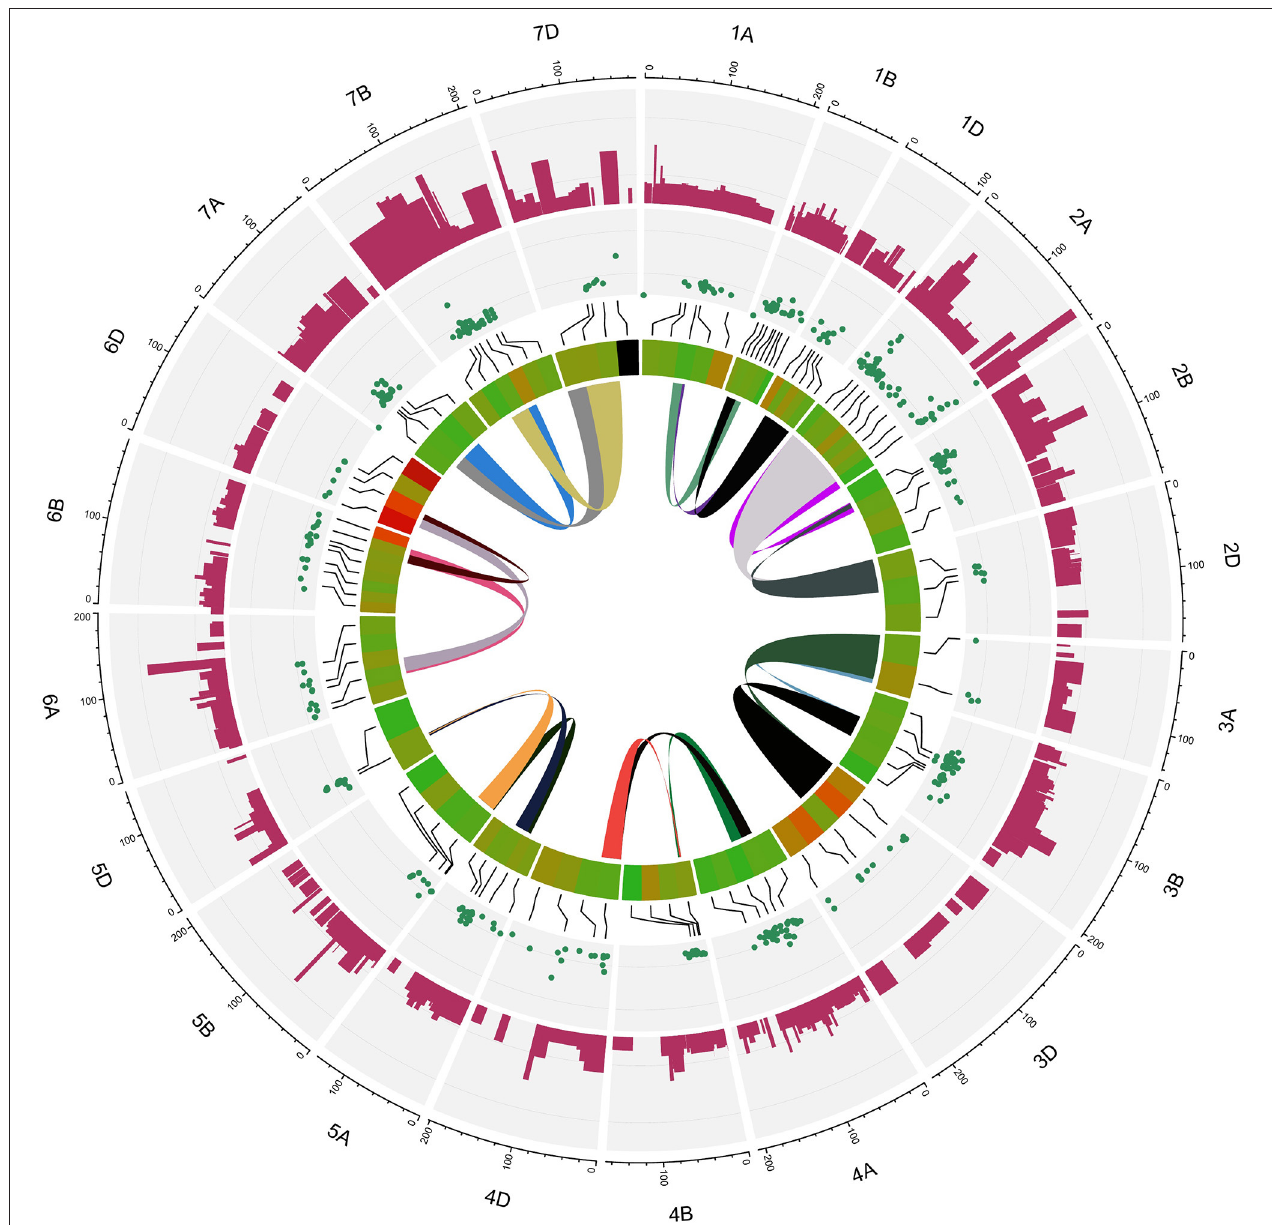
FIGURE 5 | Circus plot showing distribution of QTLs and MQTLs on 21 linkage group of wheat. The outermost circle indicates the length of each linkage map on the consensus genetic map. The second circle indicates the initial QTLs with 95% confidence intervals. The third circle displays the density of QTLs in each MQTLs. The fourth circle displays the position of detected MQTL related to assessed traits based on heatmap illustration. The last inner circle demonstrated common markers links between different genome (A, B, and D) of each linkage